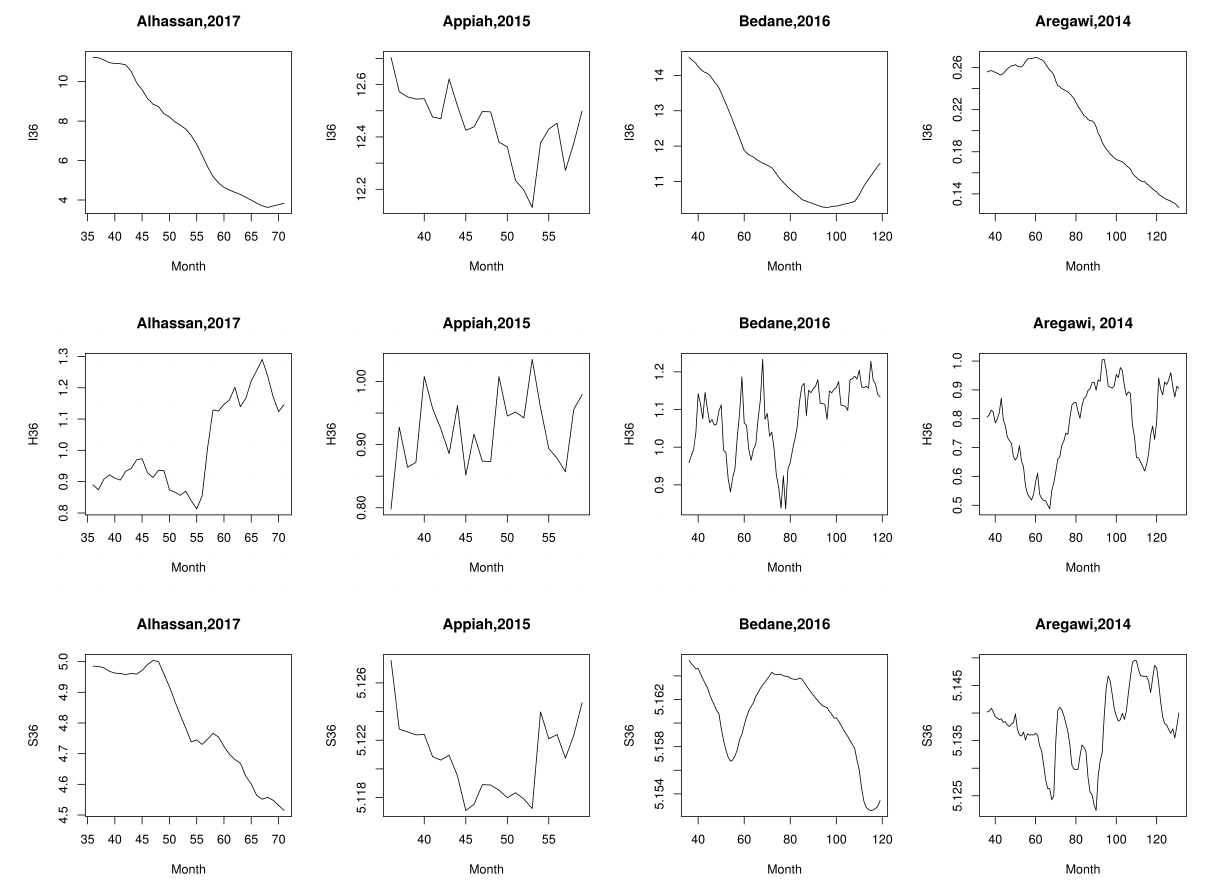
Figure A3. Comparative depiction of I 36 ( top ), H 36 ( middle ) and S 36 ( bottom ) for (from left to right) Alhassan et al. (Kasena Nankana municipality in Ghana, 2017) [21], Appiah et al. (Ejisu- Juaben municipality in Ghana, 2015) [16], Bedane et al. (Kucha district in Ethiopia, 2016) [23], and Aregawi et al. (Ethiopia, 2014) [22].